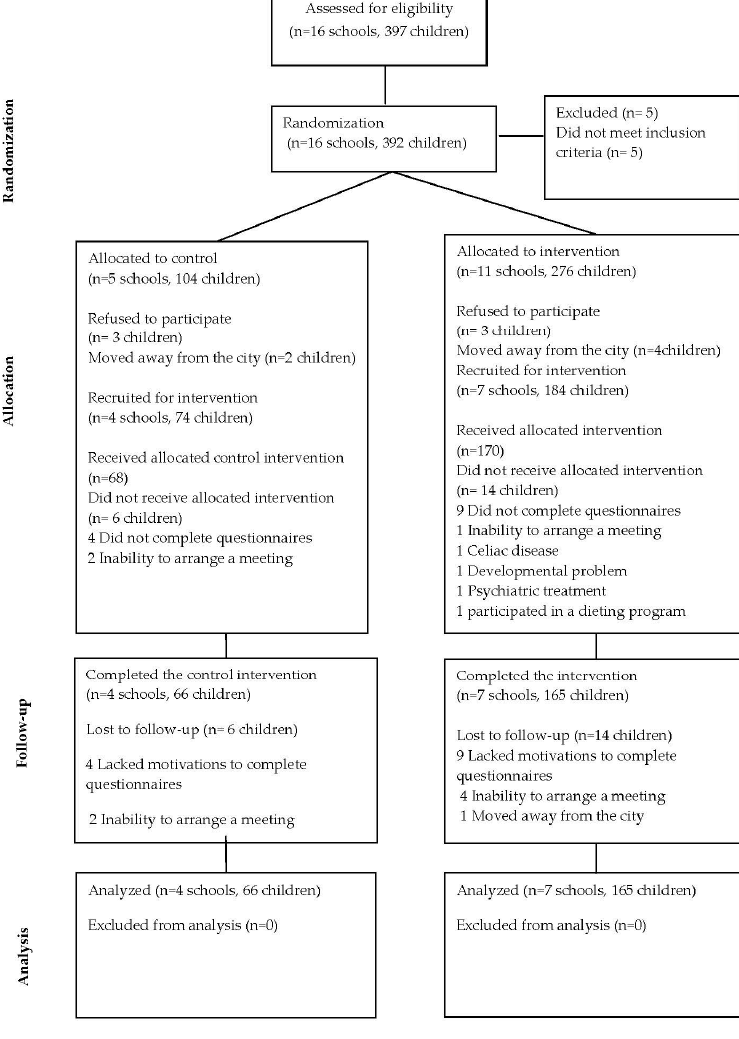
Figure 1. Flowchart of participants over the course of the study.